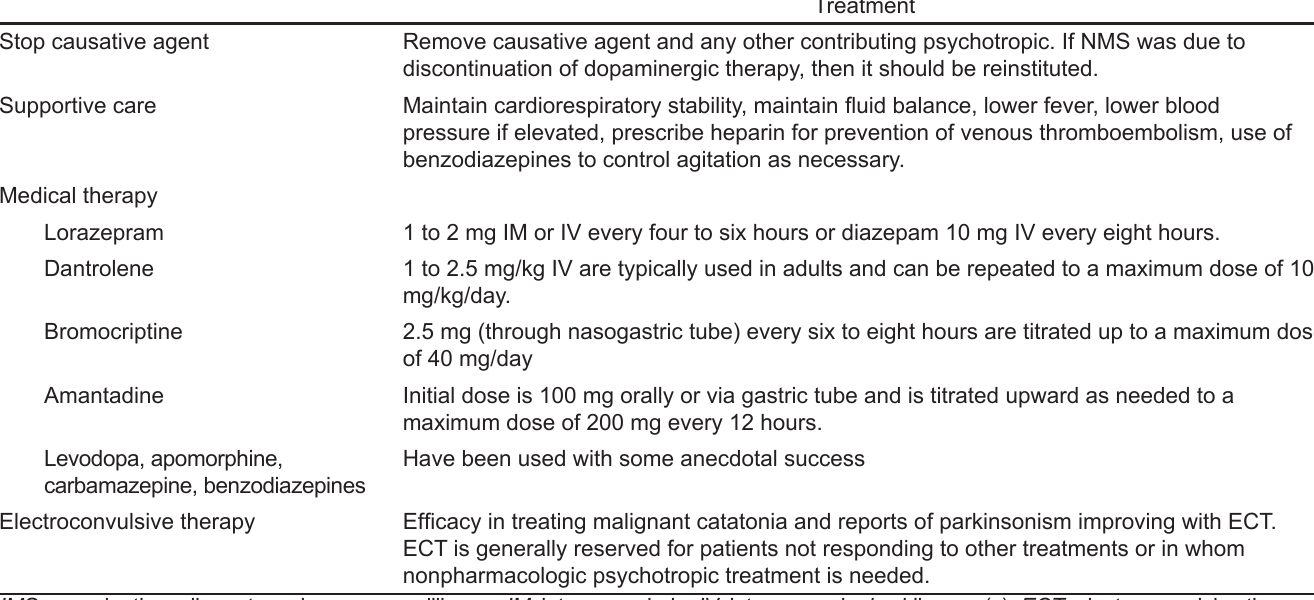
Table 5. Standard treatment pathway for neuroleptic malignant syndrome.